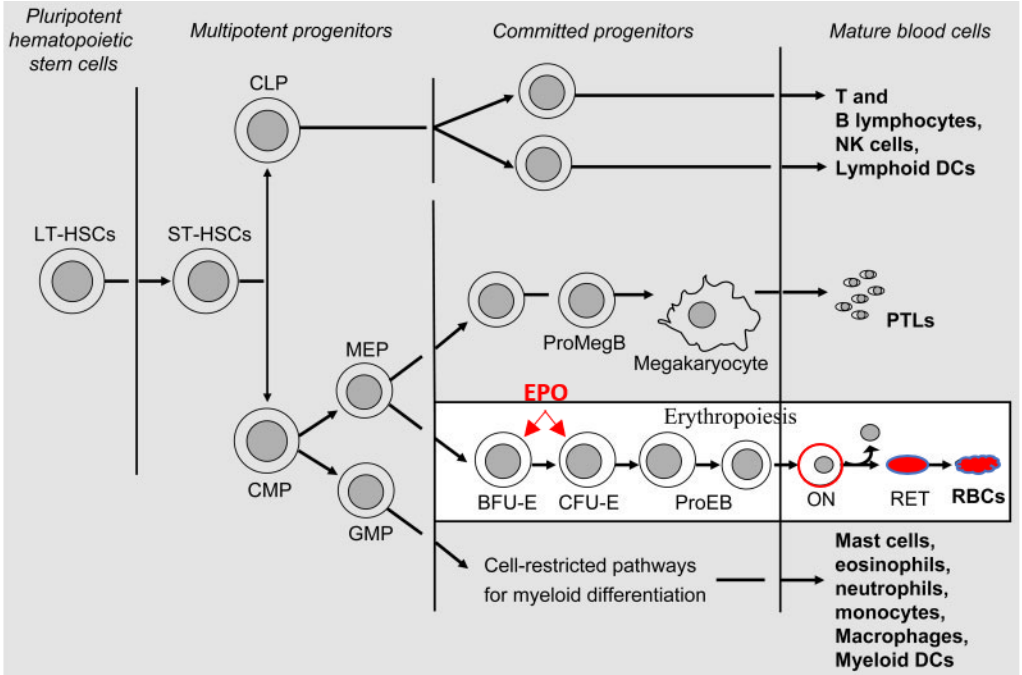
Figure 1. Illustration of the human bone marrow cell restricted pathways of the differentiation of hematopoietic stem cells into mature blood cells. In the lower right box, the erythroid cell restricted lineage differentiation is shown. HSCs give rise to common myeloid progenitors (CMP) and common megakaryocyte erythroid progenitors (MEP). The latter are differentiated into erythropoietin-responsive BFU-E and CFU-E clones, shown by the arrows where human EPO acts upon them. Interactions of EPO with its homodimeric EPO-R lead to cell signaling activation pathways that increase the biosynthesis of hemoglobin. The levels of hemoglobins increase as erythropoiesis continues in the proerythroblasts, in the orthochomatic normoblasts (ON) and finally in the reticulocytes and mature red blood cells (RBCs) following the extrusion of the nucleus. Erythropoiesis is homeostatically regulated by low-oxygen conditions (hypoxia) and the final end production via a feedback action loop. The original figure was published by Tsiftsoglou et al. [4] and has been lightly modified accordingly to indicate where EPO acts upon in the proerythroid cells. The initial commitment to the erythroid cell lineage restricted pathway of differentiation begins at the level of BM HSCs and leads to the formation of MEPs that yield BFU-Es and CFU-Es. The most recently published work by Eisele et al. [9] provided direct evidence indicating that EPO indeed acts upon the BM HSCs to promote commitment towards the erythroid maturation.